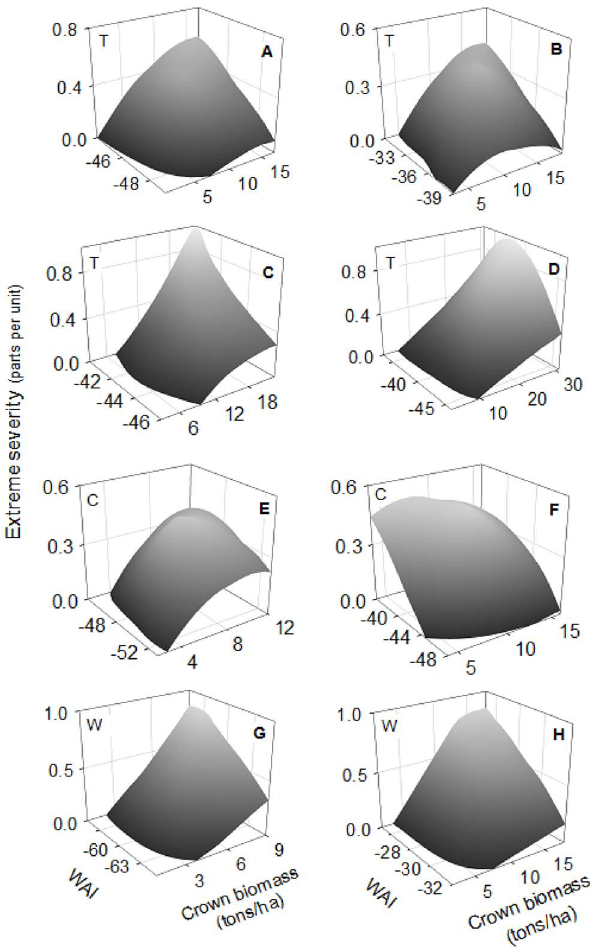
Figure 4. Significant interactions of Crown Biomass (tons/ha) and WAI on extreme fire severity (parts per unit). Letters in the top-right corner indicate the fire: (A) Castellbell i el Vilar 2003; (B) Talamanca 2003; (C) Vimbodı´ 2006; (D) Nava`s 2007; (E) Margalef 2005; (F) Rocafort 2005; (G) Riba-roja d’Ebre 2005; (H) Ventallo´ 2006. Letters in the top-left corner indicate the fire type: (T) topographic fires; (C) convective fires; (W) wind-driven fires.